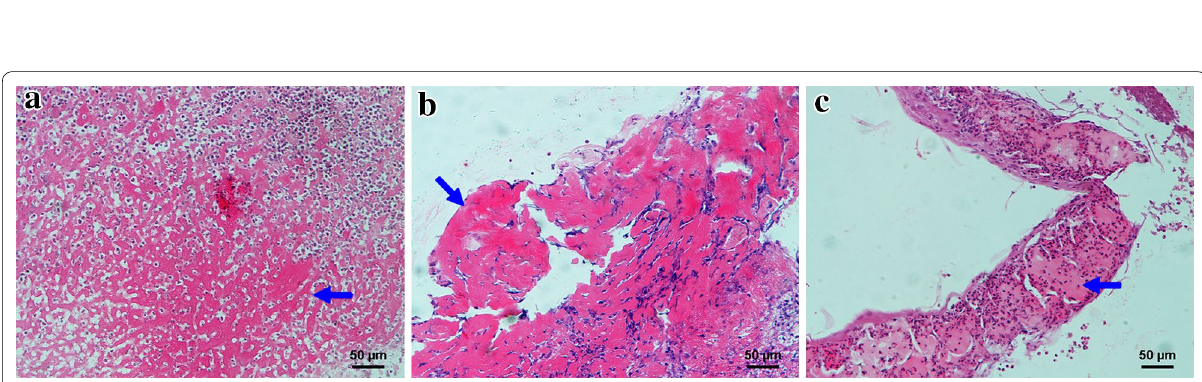
Fig. 2 Pathologic characteristics of nasopharyngeal necrosis. The three necrotic tissues ( a – c ) were taken from three NPC patients. Hematoxylin– eosin staining of nasopharyngeal necrosis is similar that shows many red-stained substances without cellular structure ( arrows